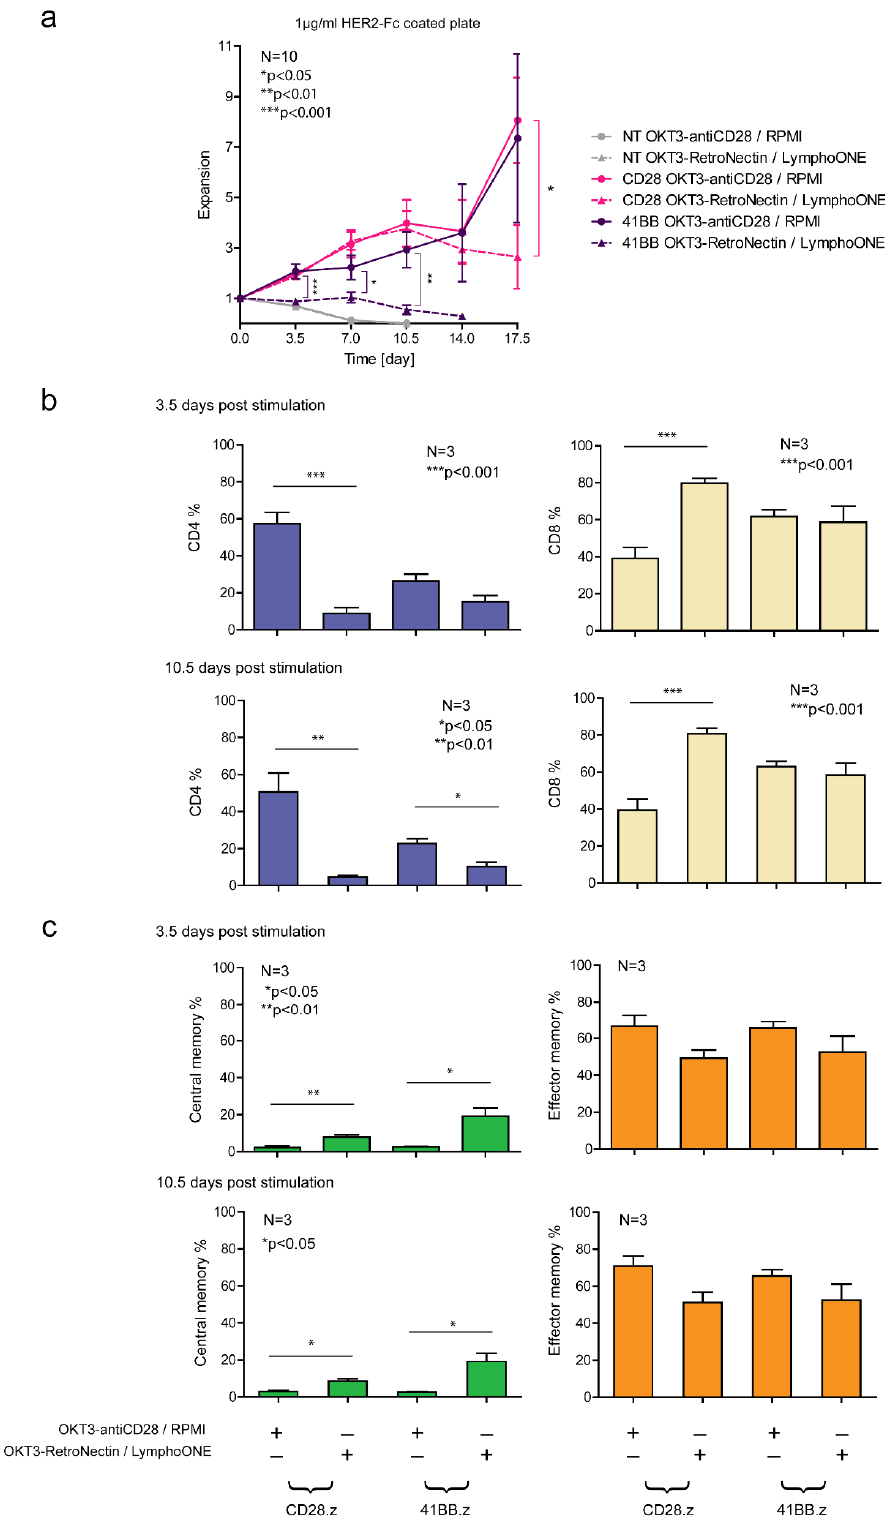
Figure 4. Phenotype distribution and persistence of antigen-stimulated HER2-CAR T cell products. Rechallenge experiment of NT and CAR T cell products prepared with two different stimulation and cell culture protocols. ( a ) NT or CAR T cells (2 × 10 5 ) were placed onto 1 µ g/mL HER2-Fc precoated plates in duplicates. Every 3.5 days, effector cell number was determined by flow cytometry. If it was available, the initial effector cell quantity was placed onto new plates in